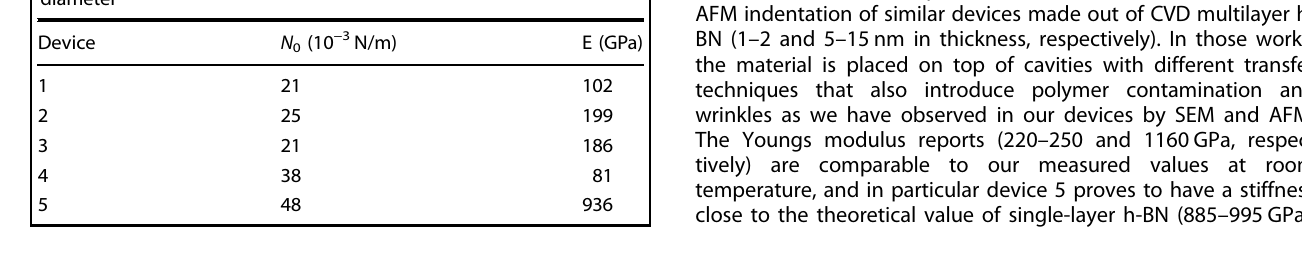
Table 2. Fundamental frequency and tension of CVD single-layer h-BN drums at room temperature from the laser interferometric technique before and after cleaning in harsh environments Before cleaning